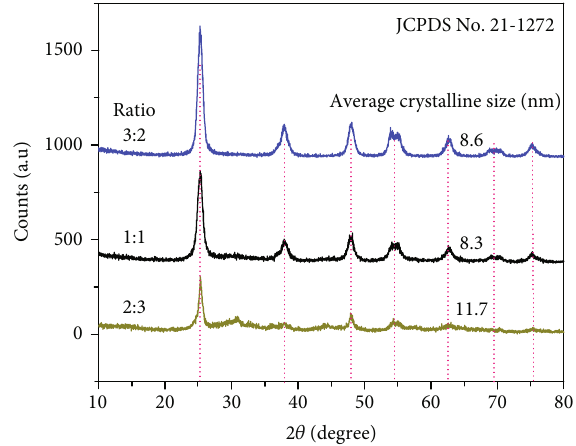
Figure 6: XRD spectra of biosynthesized TiO 0.25M Ti precursor versus the root extract of Knipho fi a schemperi